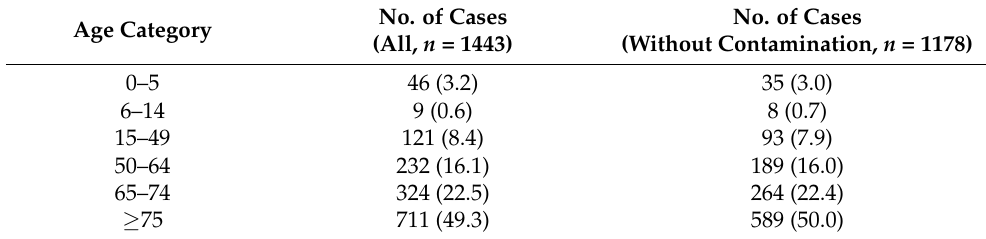
Table 1. Positive blood culture cases and cases without contamination stratified by age category.